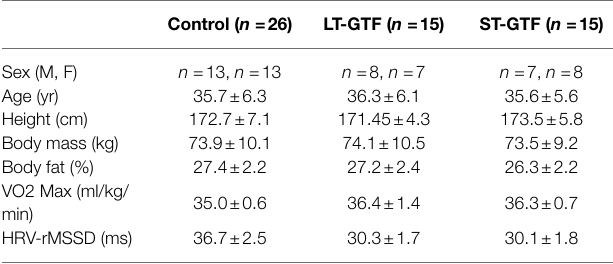
TABLE 2 | Demographics at baseline for all participants in randomized